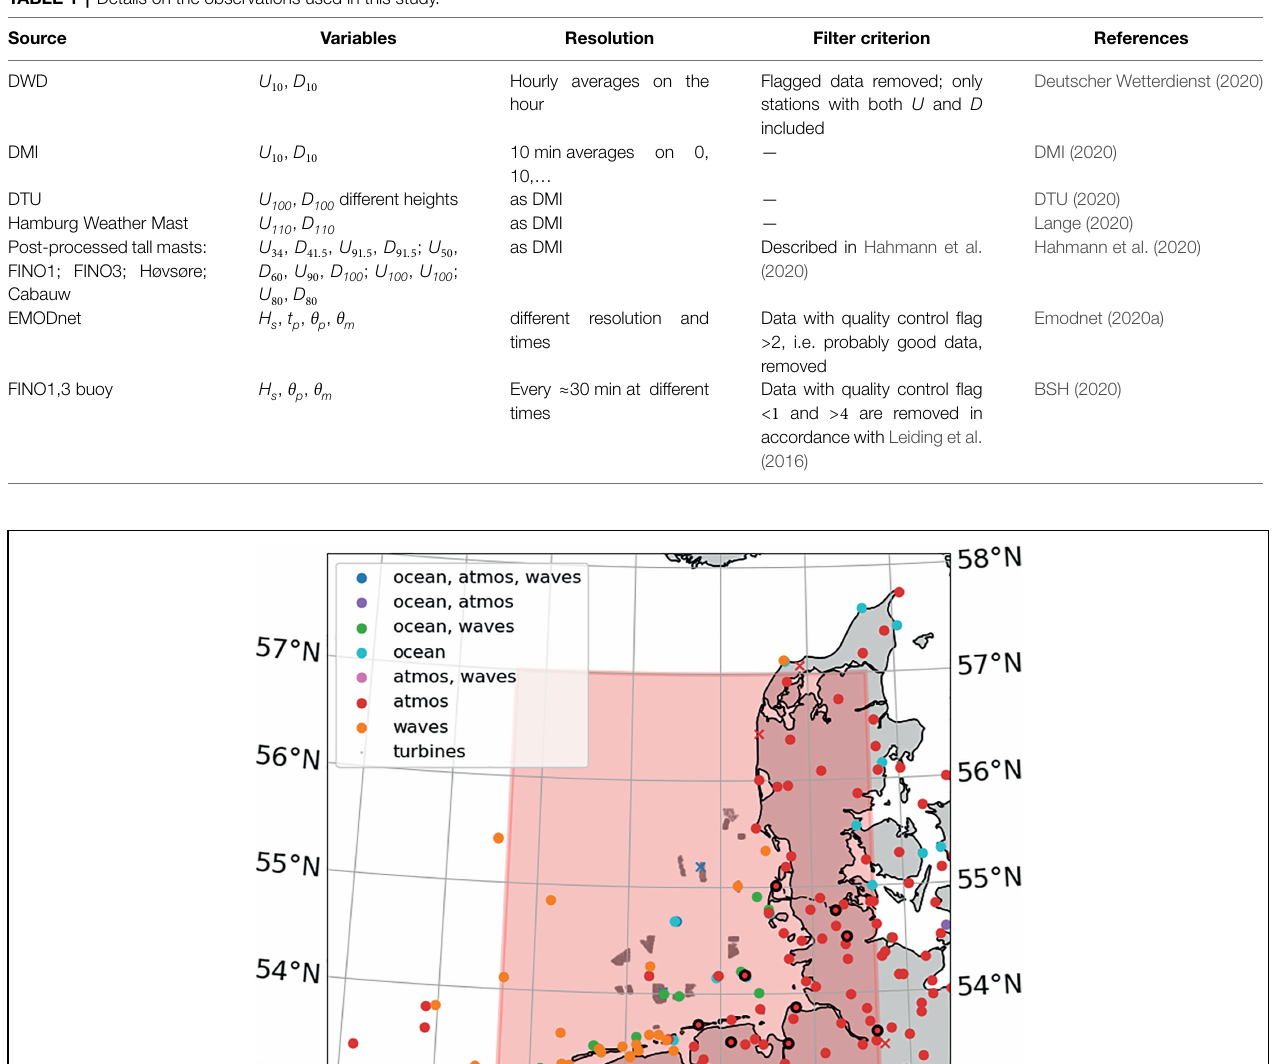
TABLE 1 | Details on the observations used in this study.